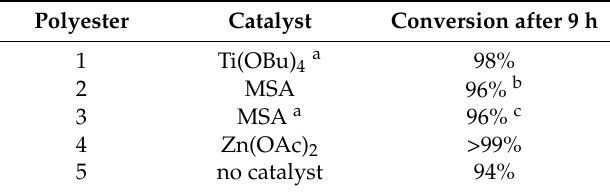
Table 1. Conversion of the catalyst screening of the polycondensation of IA with PDO.